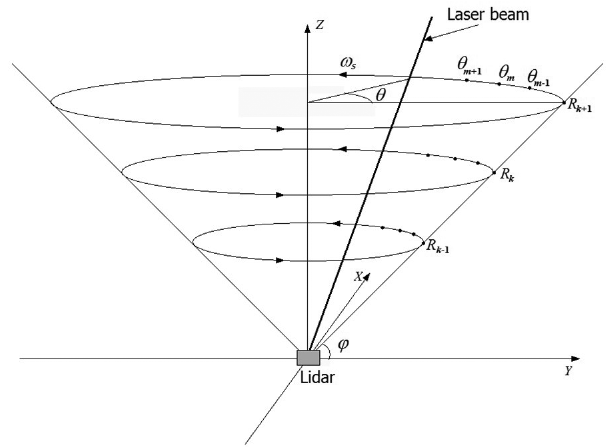
Figure 1. Geometry of measurement by a pulsed coherent Doppler lidar with the conical scanning by the laser